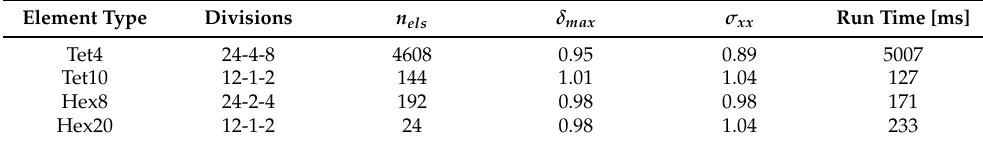
Table 2. Overview of the number of elements necessary for different element types to achieve an accuracy of at least 95% compared to the analytical solution of 6.48 mm. The run time for each analysis is included in the rightmost column. Note that n els for Tet4- and 10 are obtained by multiplying the product of Divisions with 6 as each hexahedron is divided into six tetrahedrons.